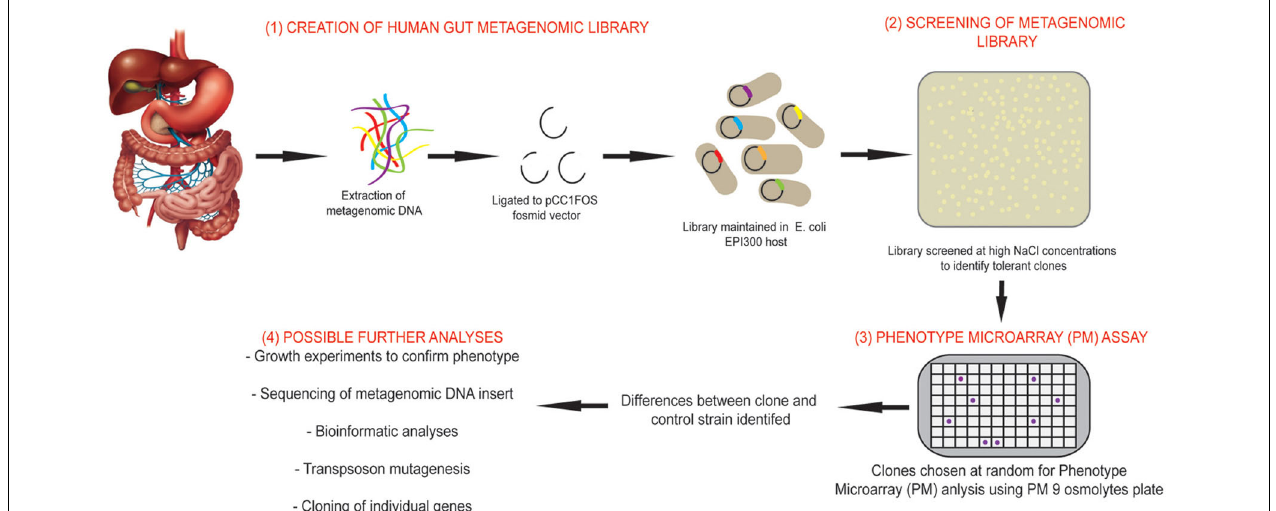
FIGURE 1 | Overview of the study design using combined functional metagenomic and phenomic approaches. An overview of the study design and experimental process incorporating metagenomic library creation and